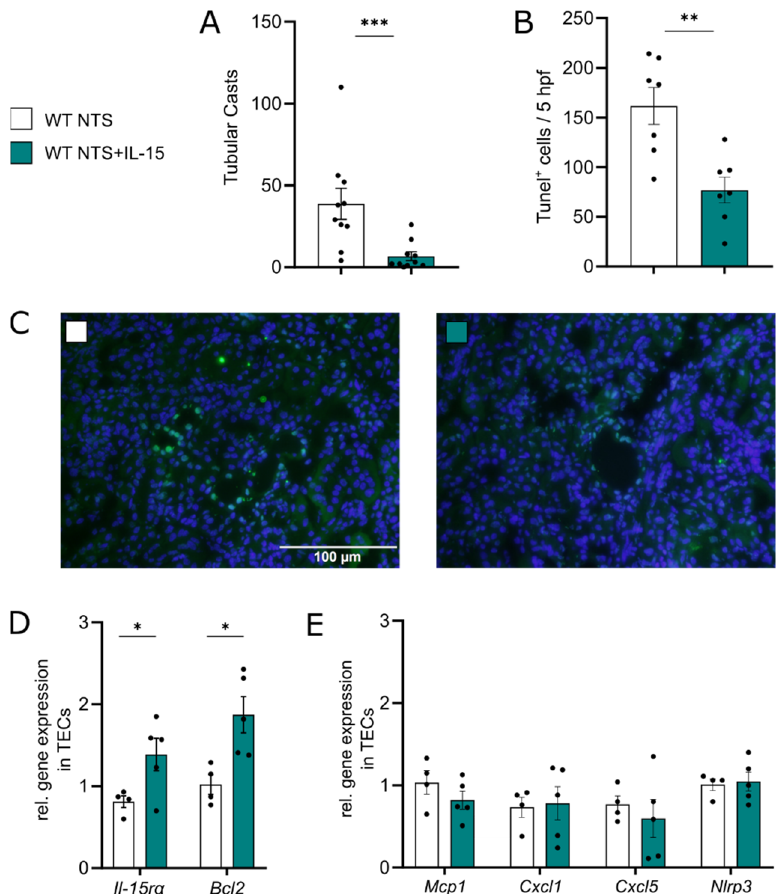
Figure 2. rIL-15 promotes TEC survival in NTS. Data represent day 7 of NTS. ( A ) Quantification of tubular cast formation in PAS-staining of kidney tissue. ( B ) Quantification of TUNEL+ cells in 5 hpfs and ( C ) representative micrographs (×40 magnification). ( D ) Relative gene expression of Il-15r α and Bcl2 and ( E ) Mcp1 , Cxcl1 , Cxcl5 , and Nlrp3 in renal tubular epithelial cells. Data in A and B represent two independent experiments. Black dots represent individual values of respective mice. * p ≤ 0.05, ** p ≤ 0.01, *** p ≤ 0.001. Statistical analysis used was Student’s t -test or Mann–Whitney test. All data are mean ±